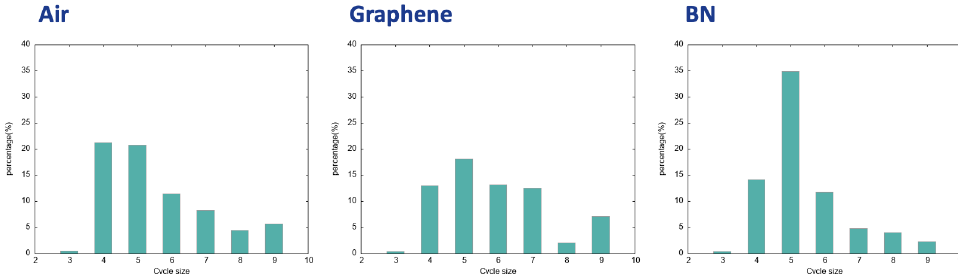
Figure 9. Distribution of the size of H-bonded rings/cycles formed by the water molecules in the 2D-MolGraphs (condensed phase). ( Left ): the air/water interface; ( Middle ): the graphene/water interface; ( Right ): the BN/water